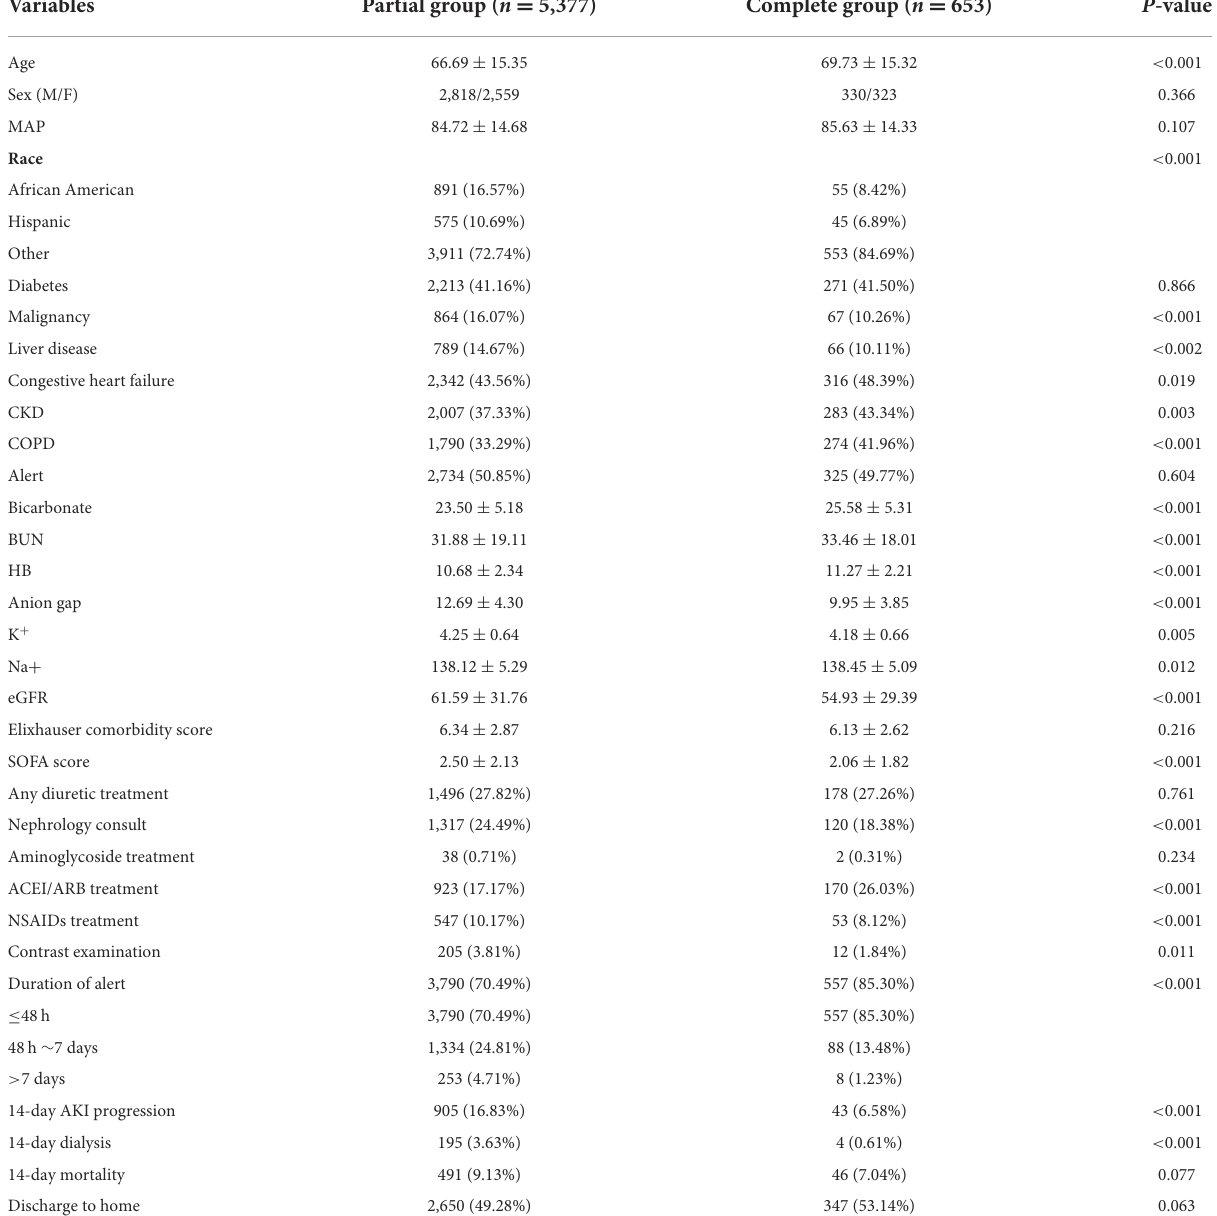
TABLE 1 The clinical characteristic of